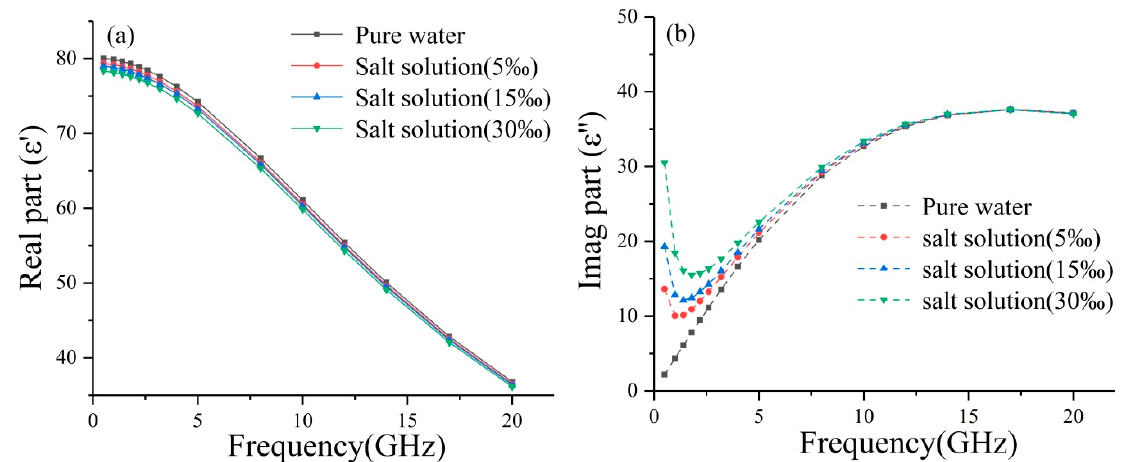
Figure 5. Complex dielectric constant of ( a ) real part and ( b ) image part of pure water and salt solutions; the models of pure water and salt solution are from [30] and [36], respectively.